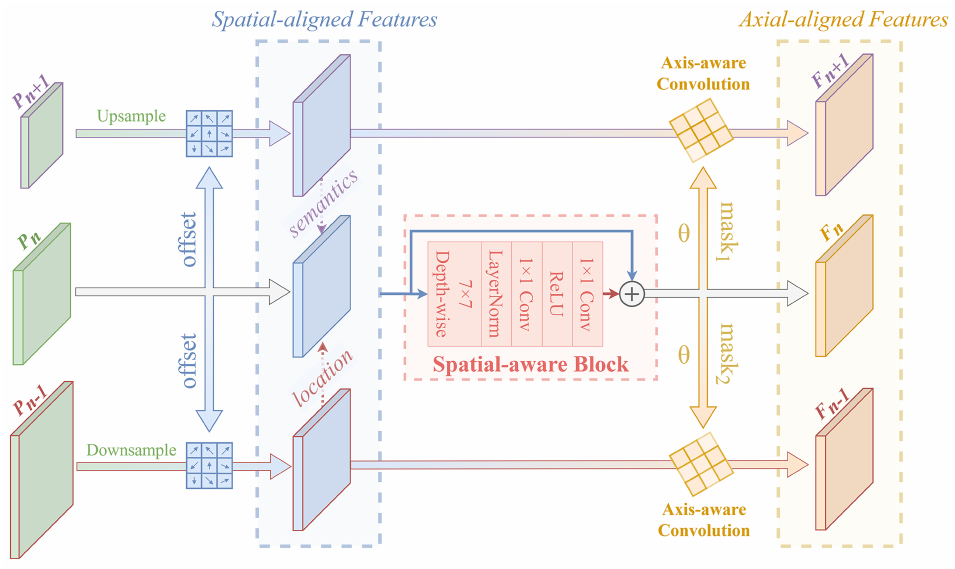
Figure 3. Structure of intra-level collaborative feature alignment